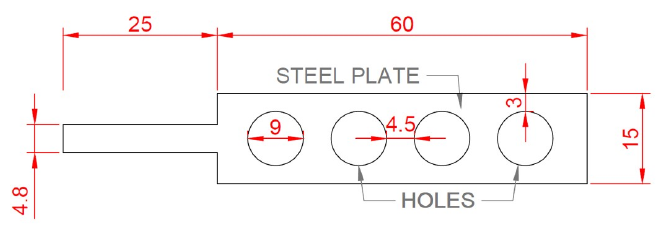
Figure 2. Rigid element vertical view (measurements in